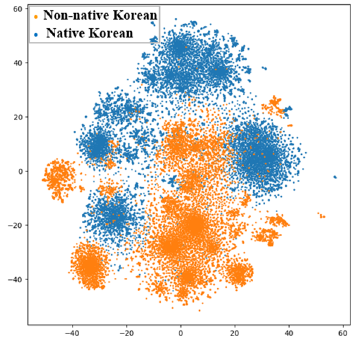
Figure 6. Spatial distribution of sequence-level attributes in the acoustic space of native/non-native Korean speech.